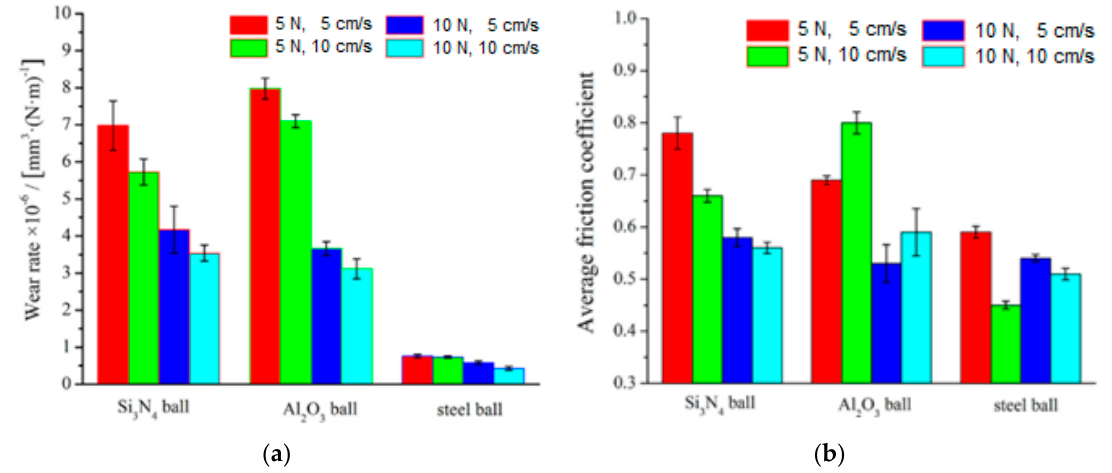
Figure 19. Wear rate ( a ) and coefficient of friction ( b ) of the systems 4 μ m thick TiN coating deposited on AISI 440C steel by means of the arc ion plating technique—Si 3 N 4 , Al 2 O 3 and steel balls, reprinted from Tribology International , Reference [137], with permission from Elsevier.